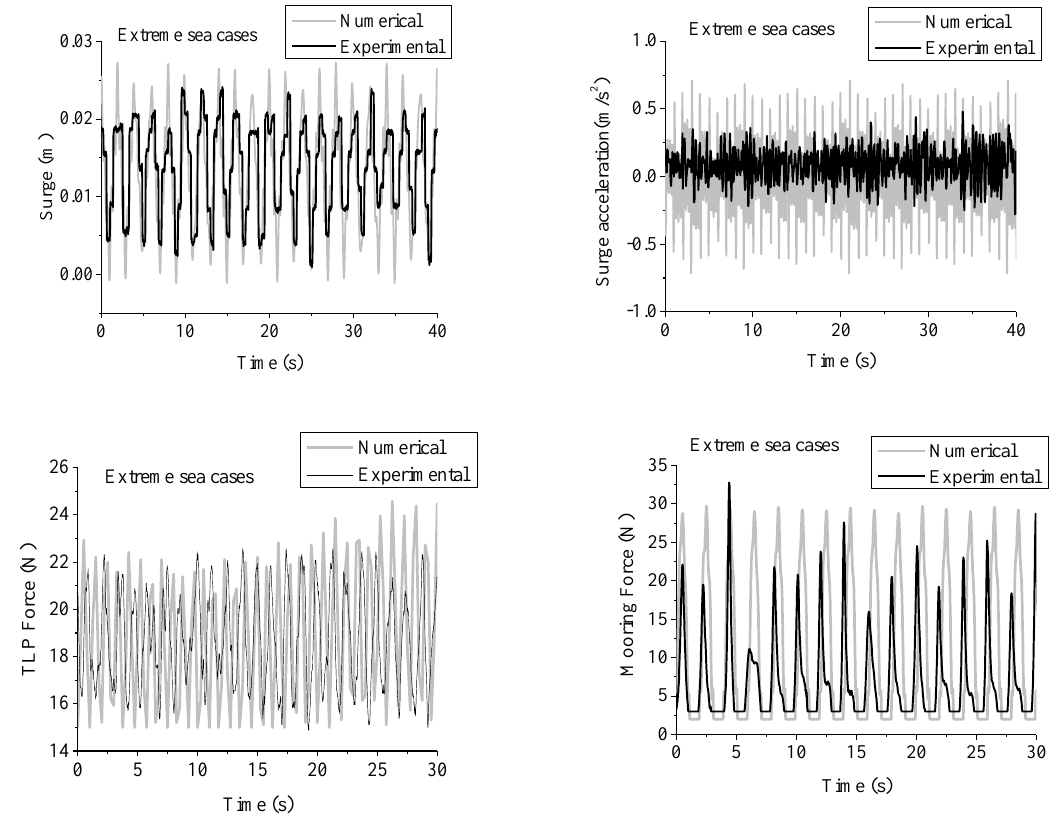
Figure 8. The comparison of the FOWT’s main dynamic responses under extreme sea case. ( a ) Surge displacement ( top left ); ( b ) Surge acceleration ( top right ); ( c ) Typical tension leg force ( bottom left ); ( d ) Typical mooring chain force ( bottom right